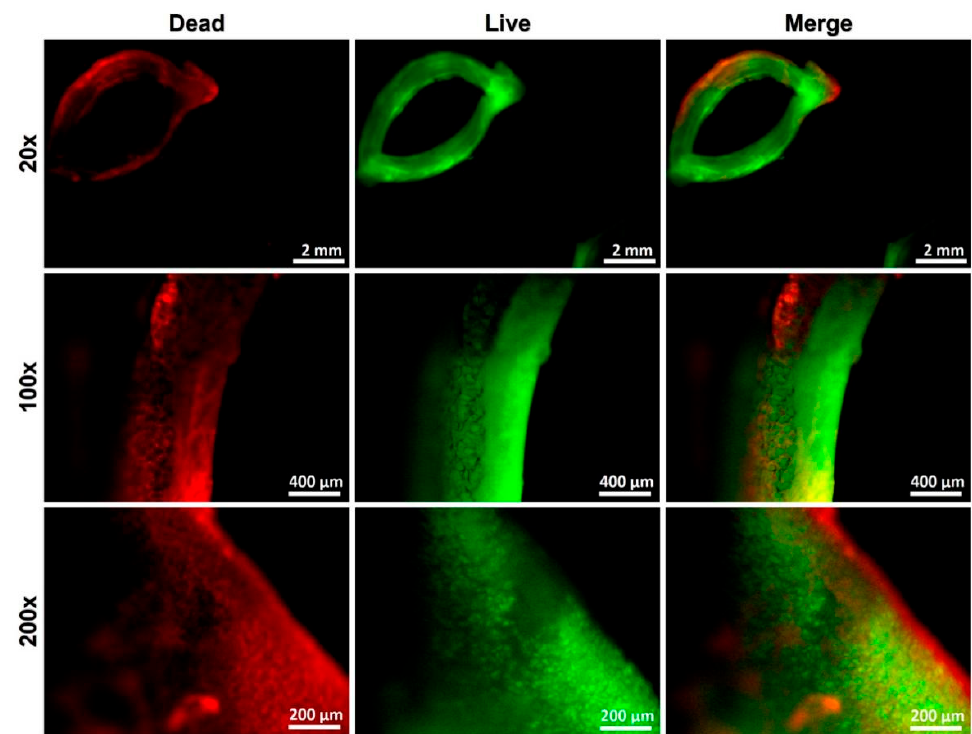
Figure 3. Vital staining of the tracheal segment immediately after the partial decellularization process. Red represents cells that have been damaged by the decellularization process, and green represents cells that are still viable. After the partial decellularization process, the cells outside the cartilage were no longer viable, but the core cells were preserved and remained potentially functional.